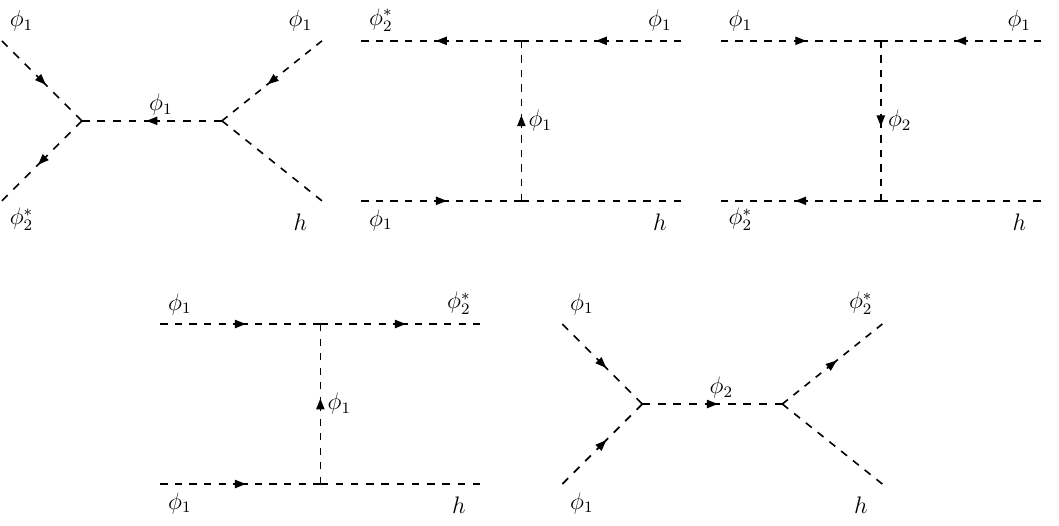
Figure 1 . Dark matter semi-annihilation processes involving one trilinear (cid:22) S 1 and one Higgs-DM (cid:21) Si interactions: (cid:30) 1 (cid:30) (cid:3) ! (cid:30) 1 h (top) and (cid:30) (cid:3) h ! (cid:30) 1 (cid:30) 1 (bottom). Replacing (cid:22) S 1 ! (cid:22) S 2 similar 2 2 diagrams arise for the processes (cid:30) 1 (cid:30) 2 ! (cid:30) 2 h (top) and (cid:30) 2 (cid:30) 2 ! (cid:30) 1 h (bottom).